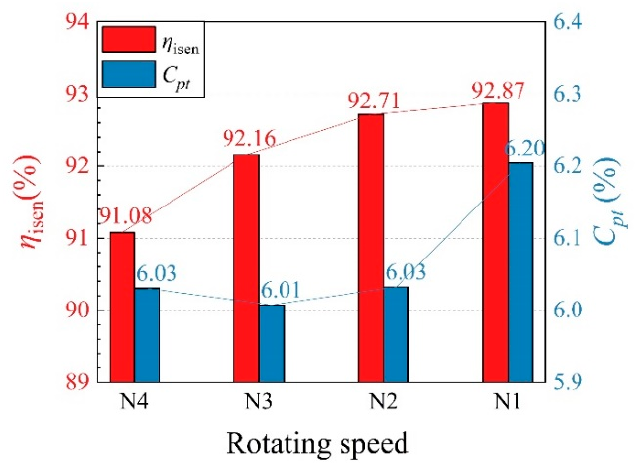
Figure 16. Aerodynamic performance of the tandem rotor and stator at PEP of N1, N2, N3, and N4.